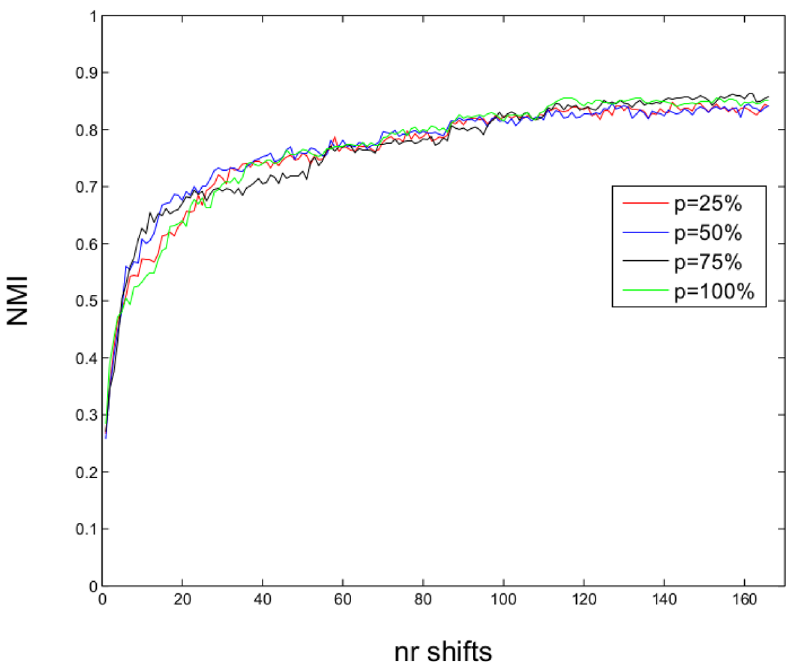
Fig 8. Evolution of the mean NMI values over time for the GN z out = 8 set and different p values.